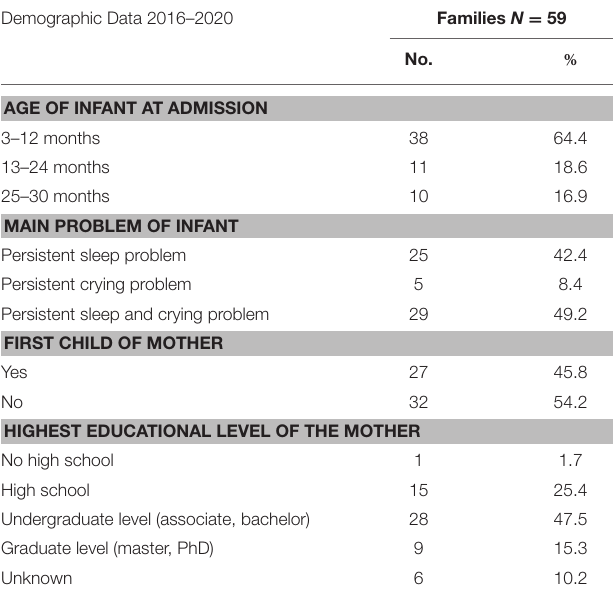
TABLE 1 | Demographics of admitted families of infants with persistent sleep and/or crying problems between 2016 and